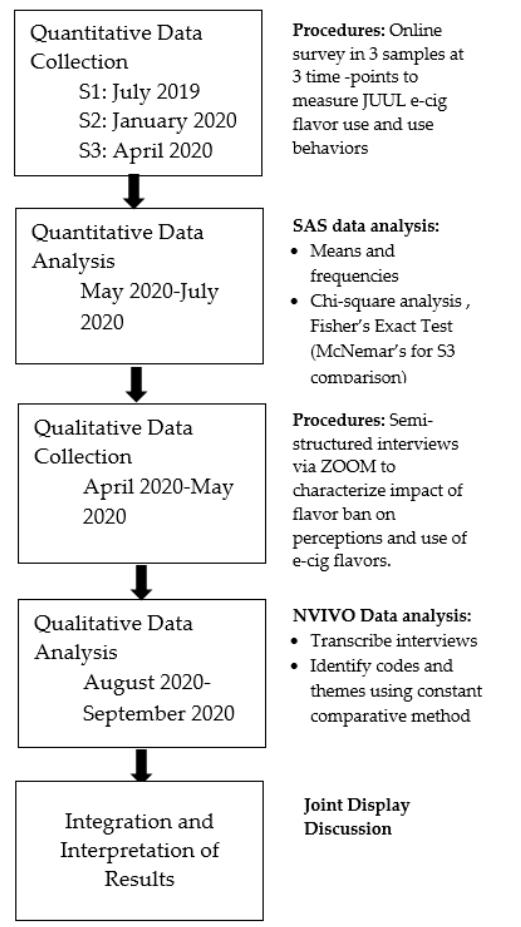
Figure 1. Procedural Diagram.